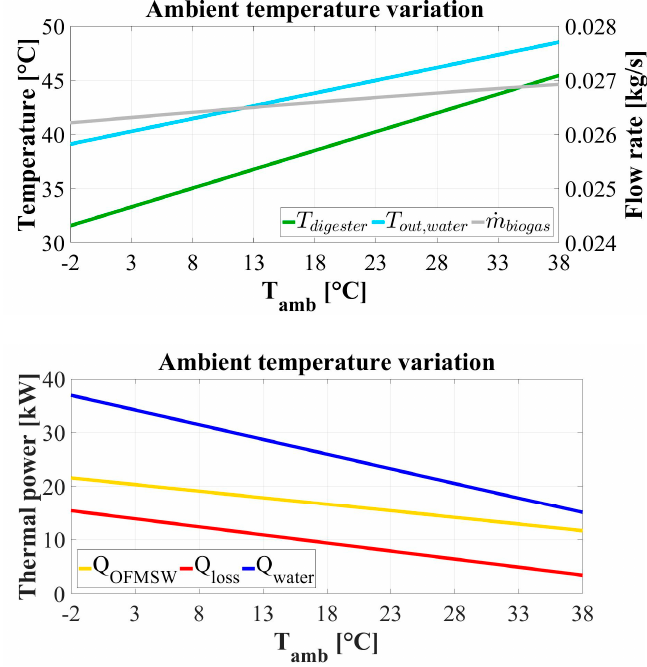
. . . Q & , Q & , Q & (below) vs. T Q OFMSW , Q loss , Q water (below) vs. amb OFMSW loss water